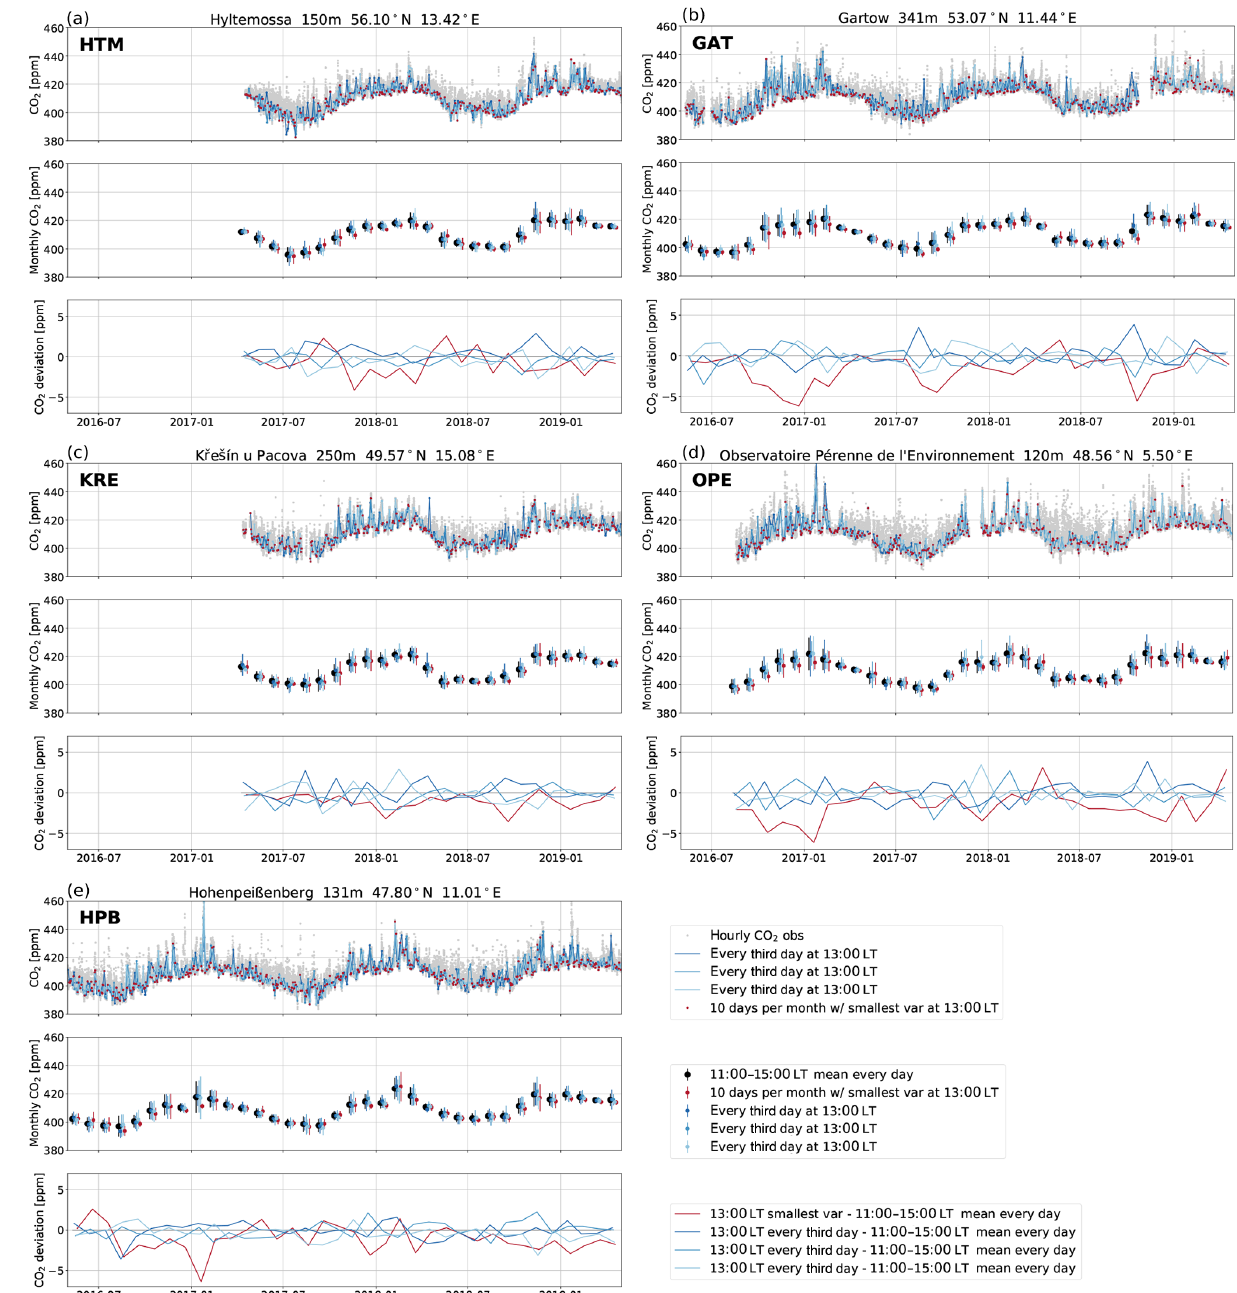
Figure 5. CO 2 concentration data measured at Hyltemossa (a) , Gartow (b) , Kˇrešín (c) , Observatoire Pérenne de l’Environnement (d) , and Hohenpeißenberg (e) . For each station the upper panel shows all hourly data as grey dots, while afternoon data (13:00LT) from every third day are displayed as three blue lines shifted by 1d each. Red dots highlight the 10 afternoon values with the lowest variability for each month. The middle panels show monthly means and standard deviations of all afternoon hours (11:00–15:00LT) as black dots, respective means from afternoon data collected every third day are shown in blue, and means of the 10 afternoon values with the lowest variability are shown in red (for better visibility the coloured dots were shifted by 1d each). The lower panels present the differences in the selected afternoon means from the respective mean calculated from all afternoon